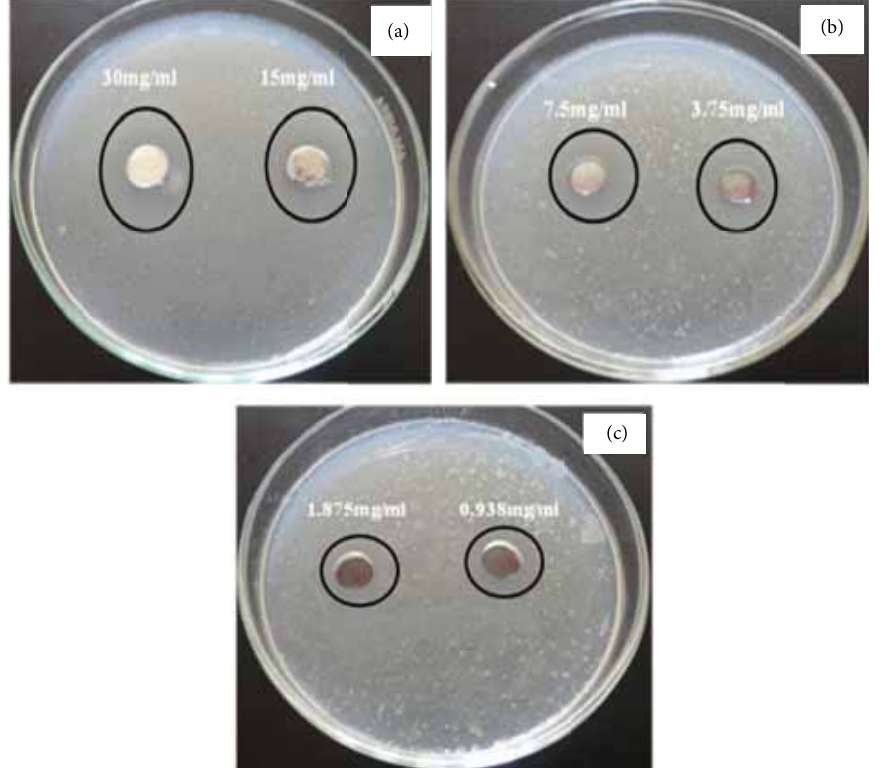
Figure 20: The antimicrobial activity of zinc oxide nanotubes against Bacillus subtilis using disc diffusion method. ((a), (b), and (c)) Different concentrations of the synthesized